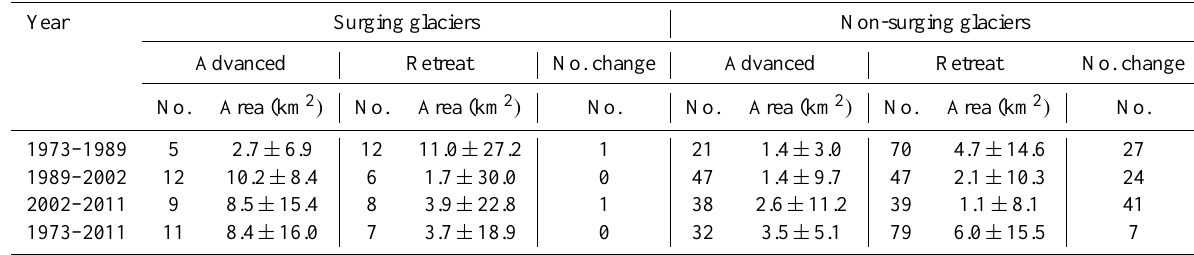
Table 2. Area (km 2 ) and number changes of surging and non-surging glaciers in upper Shyok valley during 1973–2011. Year Surging glaciers Non-surging glaciers Advanced Retreat No. change Advanced Retreat No. change No. Area (km 2 ) No. Area (km 2 ) No. No. Area (km 2 ) No. Area (km 2 ) No.